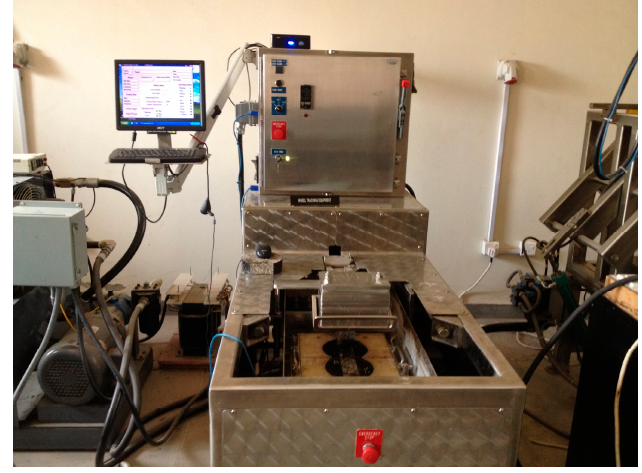
Figure 8. Hamburg Wheel Tracking Device and specimen setup.